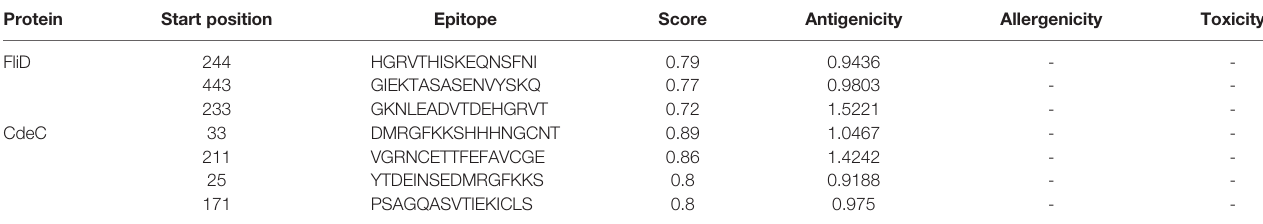
B-cell epitopes predicted using ABCpred server. The start position represents the starting site of the fi rst amino acid residue of the epitope. The default minimum threshold value of the score was set at 0.51. Epitopes with antigenicity score>0.4 are considered to be antigenic, which can speci fi cally bind to the antibodies or sensitized lymphocytes "-" refers to negative.